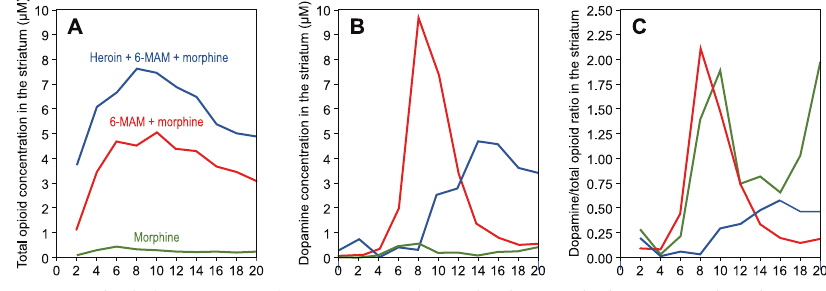
Fig. 5 Comparative analysis of total opioid and dopamine concentrations in the rat striatum. Striatal concentration of opioids and dopamine in rats that had received an i.v. injection of 1.3 µmol ( ≅ 4 mg/kg) of heroin (blue line), 6-MAM (red line), or morphine (green line). A The total concentration of the injected opioid and its metabolites. Thus, the blue line represents the sum of heroin, 6-MAM, and morphine; the red line represents the sum of 6-MAM and morphine; the green line represents the sole morphine. B The concentrations of Dopamine in the same animals. C The ratio between the concentration of dopamine (DA) and the cumulative concentration of opioids: blue line = DA/ (heroin + 6-MAM + morphine), red line = DA/(6-MAM + morphine); green line DA/morphine. Based on data extrapolated from Gottås et al. 2014 [20] (same animals of Fig.